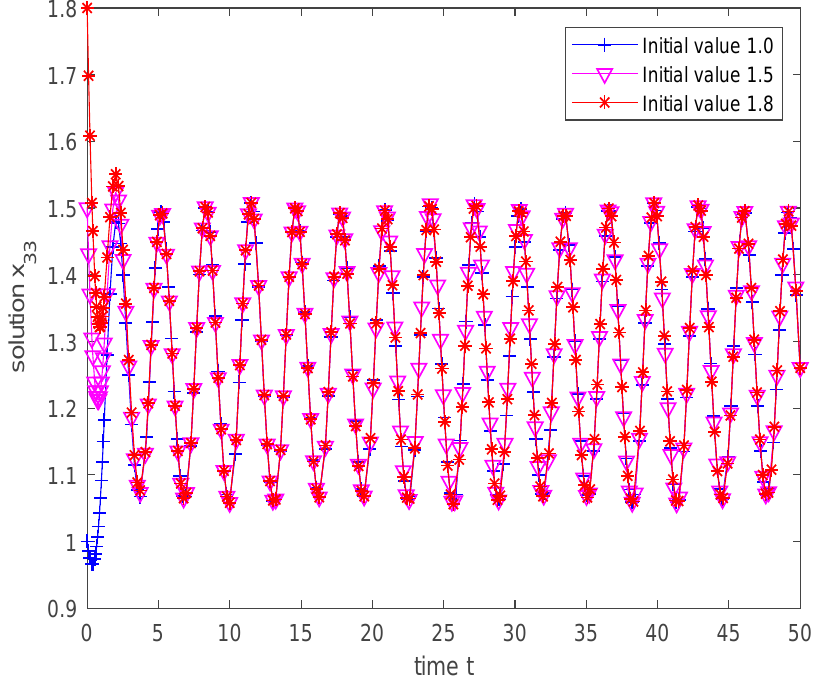
Figure 3. The state trajectory of x 33 , and initial values are 1.0,1.5,1.8, respectively.